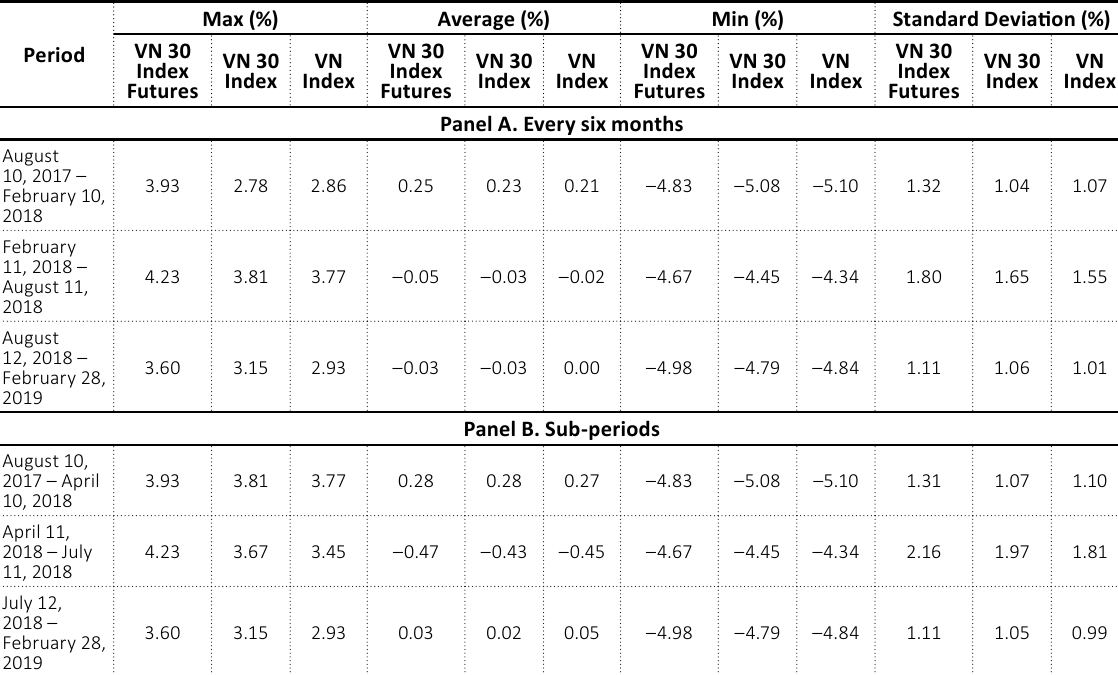
Table 2. Statistics of VN Index, VN 30 Index, and VN 30 Index Futures return